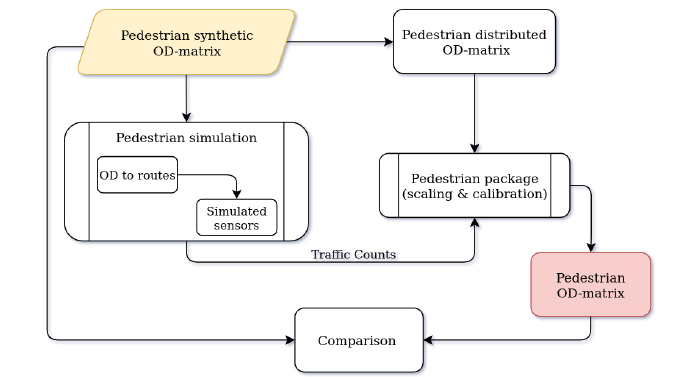
Figure 12. Validation process of the scaling and calibration model within the pedestrian